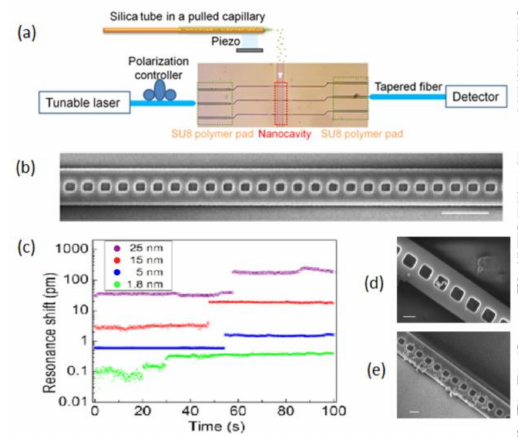
Figure 1. Gold nanoparticle detection system: ( a ) Approach based on the photonic crystal (PC) nanobeam device and piezospray introduction of the test sample; ( b ) Scanning electron microscopy (SEM) image of the nanobeam cavity (top view). Scale bar: 1 µ m; ( c ) resonance shifts caused by attached nanoparticles with diameters of 25 nm (purple), 15 nm (red), 5 nm (blue), and 1.8 nm (green); ( d ) SEM image of nanoparticles deposited in the center region when the cavity resonance was excited; ( e ) SEM image of nanoparticles deposited randomly along the waveguide when the laser is off. Scale bar: 200 nm. Adapted with permission from reference [59]. Copyright (2015) American Chemical